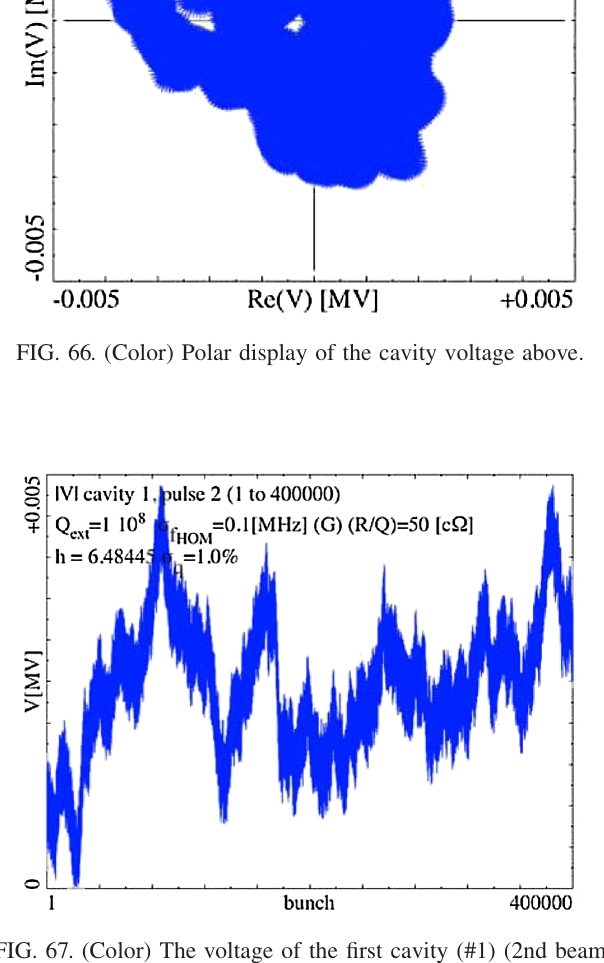
FIG. 69. (Color) The voltage of cavity (#150) from passage of bunch 1 to 400 000 (2nd beam pulse). The wiggle is a beating between the cavity HOM frequency and the frequency corre- sponding to the excited beam position modulation ‘‘sitting on the best compromise.’’ The voltage does not start at zero but at the remainder of the 1st pulse after the pulse pause (observation during the 2nd